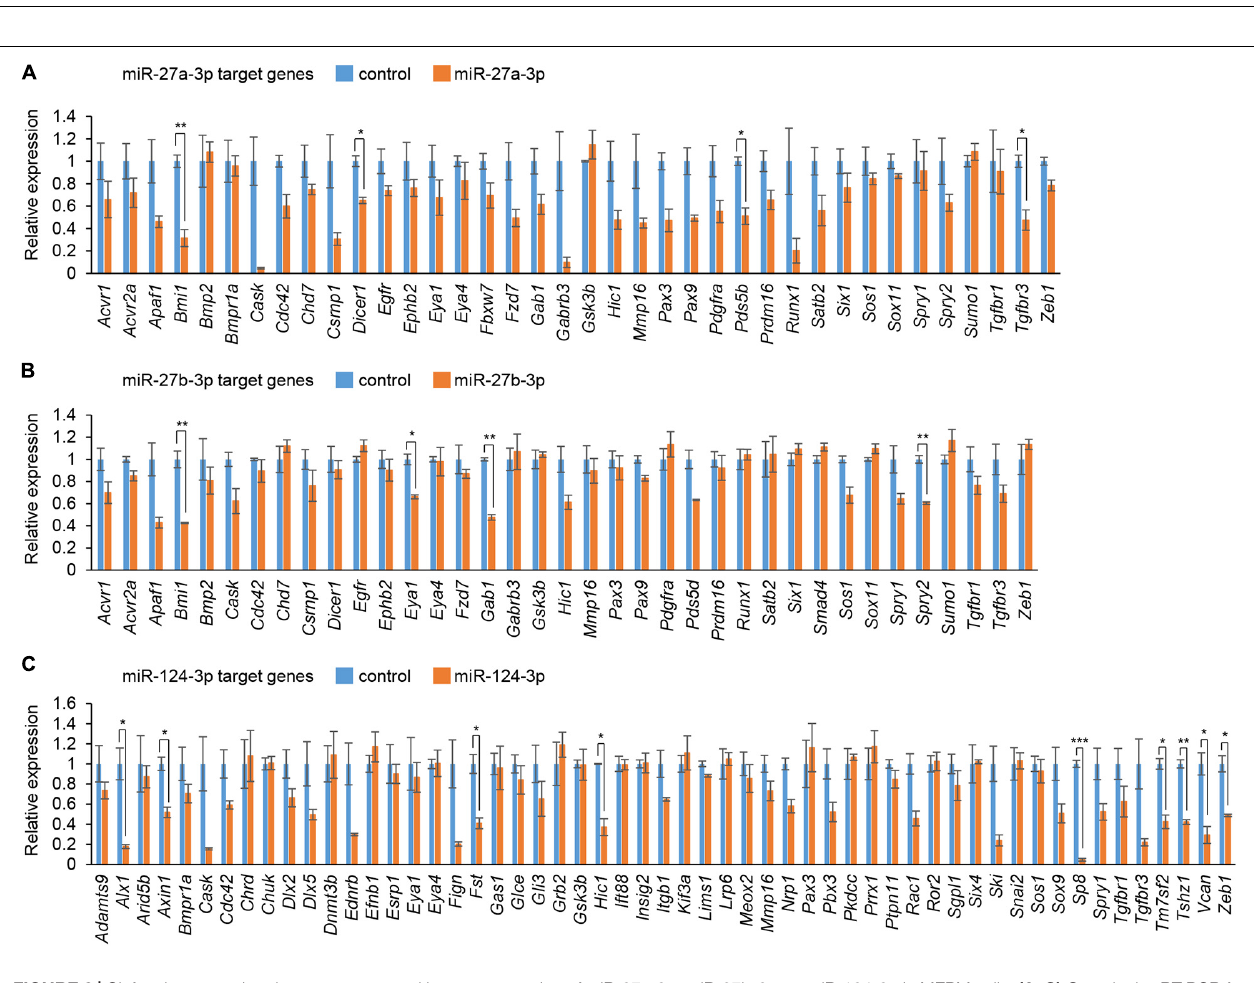
Frontiers in Cell and Developmental Biology |